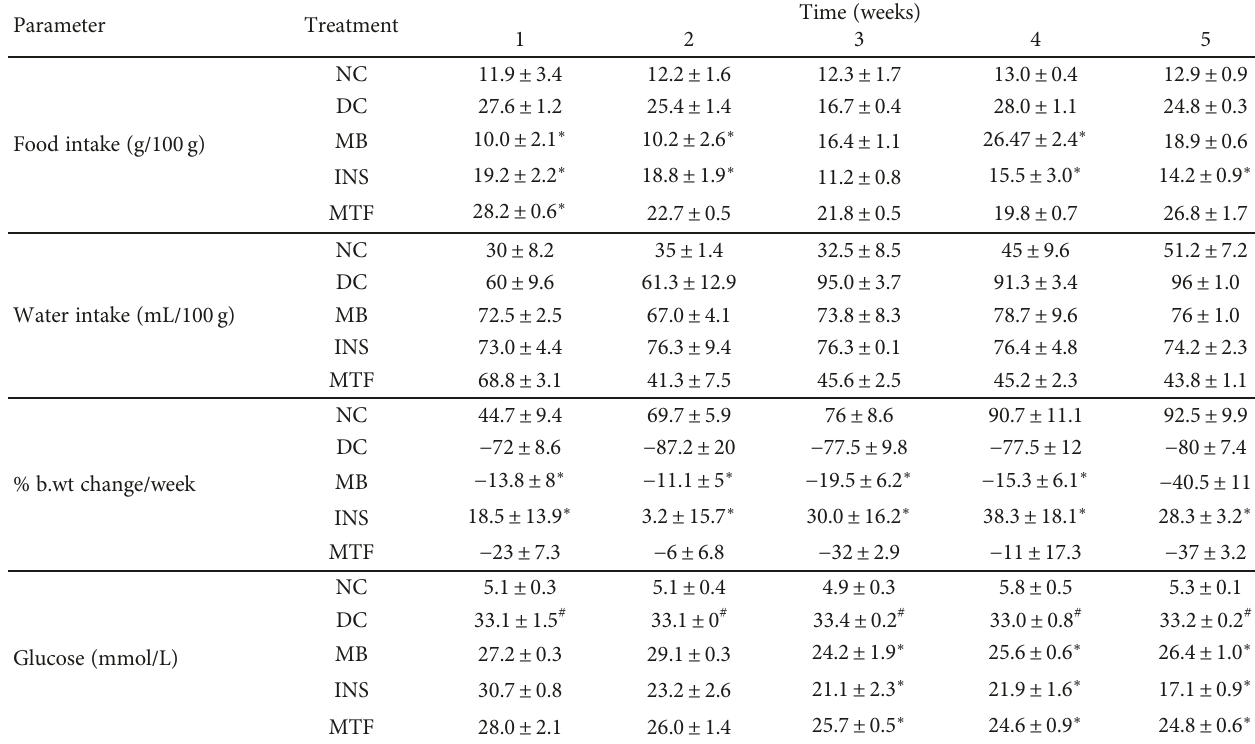
Table 1: Comparison of food, water intake, and body weight (b.wt) change of nondiabetic controls, diabetic controls, and diabetic rats treated with MB, metformin, and insulin during a 5-week study ( n = 6 in each group). Values are expressed as mean ± SEM . Parameter